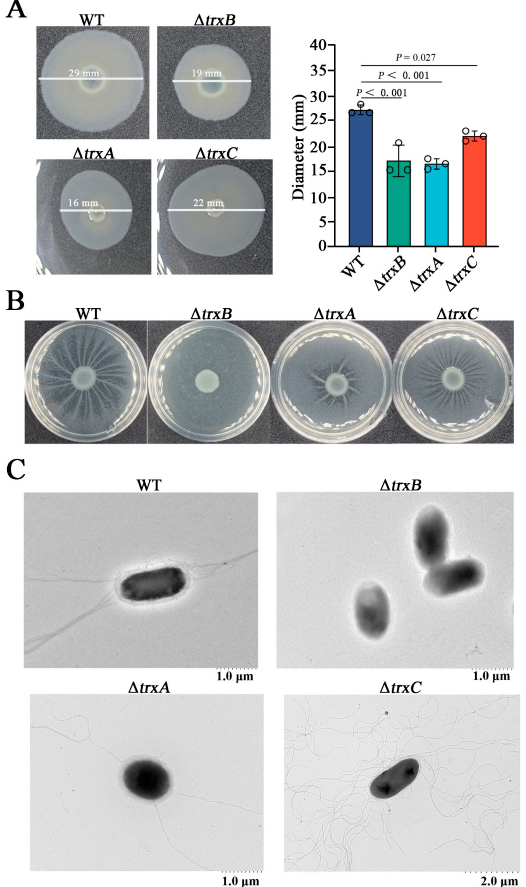
Figure 4. The effects of the thioredoxin system mutations on bacterial motility and flagellum for ‐ mation. ( A ) The swimming of Edwardsiella piscicida . WT, Δ trxB , Δ trxA , and Δ trxC were cultured in LB medium to an OD 600 of 0.6, and 1 μ L cell suspensions were spotted onto the center of swimming plates containing LB medium plus 0.3% ( w/v ) agar. The plates were incubated at 28 °C for 24 h, and the motility zone diameter was measured. ( B ) The swarming of E. piscicida . Bacteria as described above were spotted onto the center of swimming plates containing LB medium plus 0.6% ( w/v ) agar and were incubated at 28 °C for 24 h. ( C ), the flagellum observation of E. piscicida . WT, Δ trxB , Δ trxA and Δ trxC were grown in LB medium, and the flagella were observed using the TEM. Data are presented as the means ± SEM (N = 3). N, the number of times the experiments were performed. p values were obtained by analysis of variance using SPSS 23.